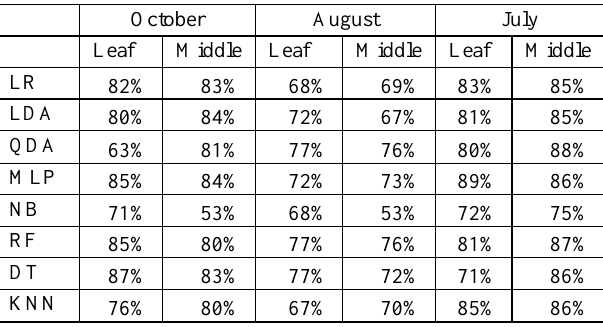
Table 2. Prediction accuracies for Vinhão in three campaigns Best results in October campaign were achieved by MLP and